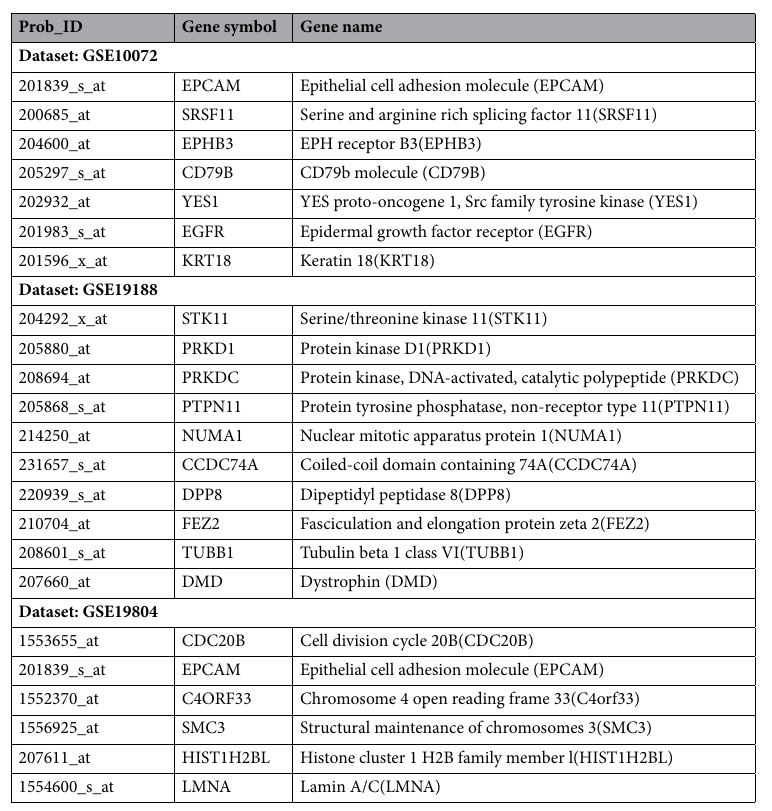
Table 6. The genes are selected by the LogSum + L 2 penalized logistic regression model for different